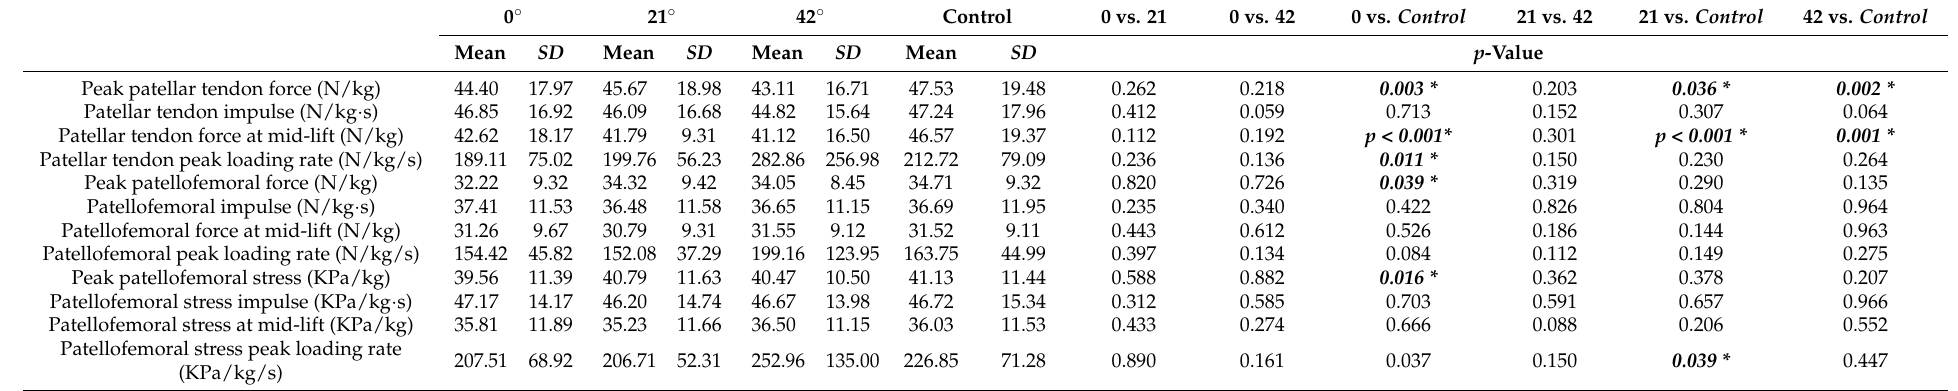
Table 8. Knee forces (mean ± SD) and statistical comparisons as a function of each experimental